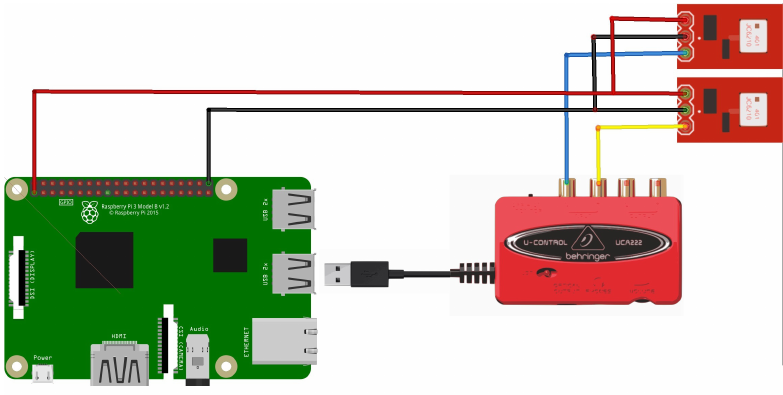
Figure 5. Schematic of electrical connections for the sound acquisition. The signal of ADMP401 microphone is acquired by means of Behringer UCA222 USB audio card which is connected to the Raspberry Pi